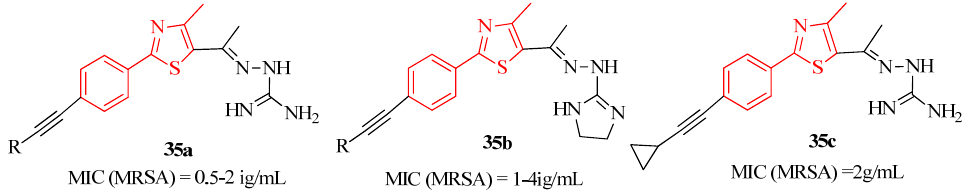
Figure 13. Structure of phenylthiazoles with alkynyl side chain.